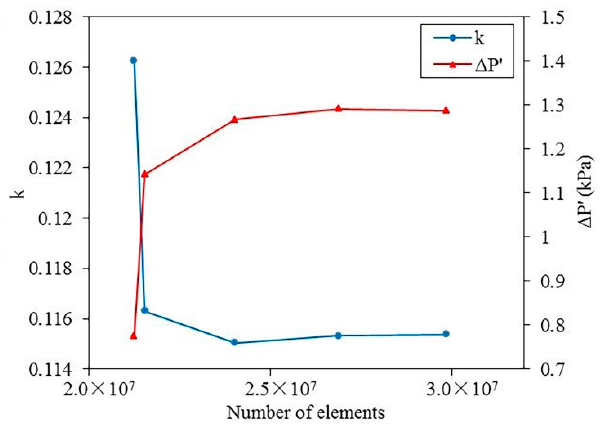
Figure 6. Grid independence validation.